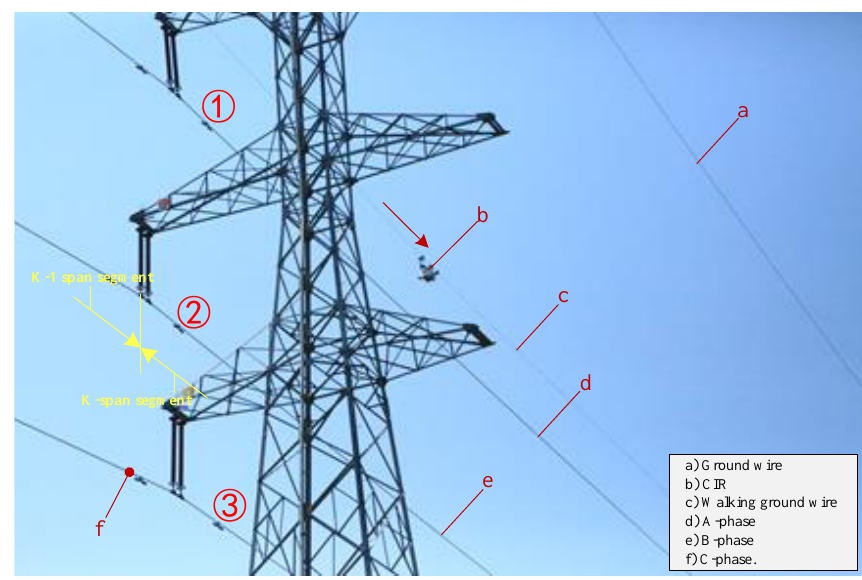
Figure 20. A photo of the actual line.